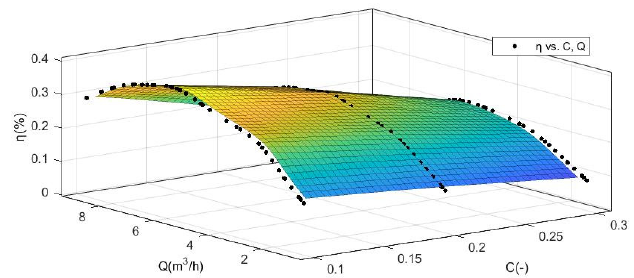
Figure 4. Fitting graph of pump efficiency data.